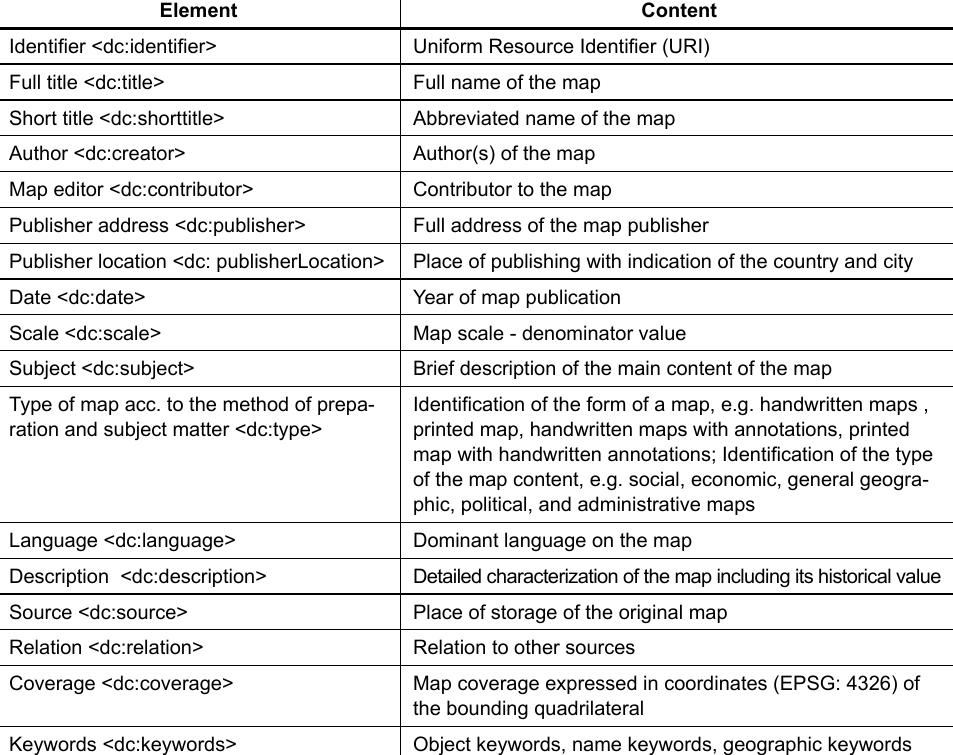
Table 1. Elements of metadata compliant with the Dublin Core standard and their